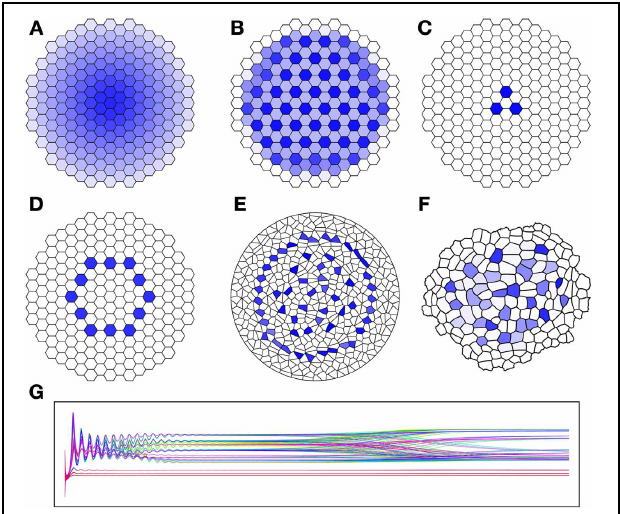
FIGURE 1 | Results of Brusselator simulation showing affect of ratio of diffusion constant and geometry on simulation. (A–F) The concentration of species A in the brusselator (30) is shown, with higher concentration given in dark blue, and zero concentration in white. (A) D A = D B = 1; (B) D A = 0, D B = 0 . 1 ; (C) D A = 0, D B = 1; (D–F) all use D A = 0, D B = 0 . 5 on different cellular teimplates. (G) Time course of the concentration of species A for all cells in simulation B (total of 199 cells). Each curve gives the concentration for different cell. Simulation E uses a Voronoi template of 500 randombly placed centers, and F uses a actual Arabodopsis meristem L1 segmentation. Parameters: a = 0 . 1, β = 0 . 1, c = 0 . 1.